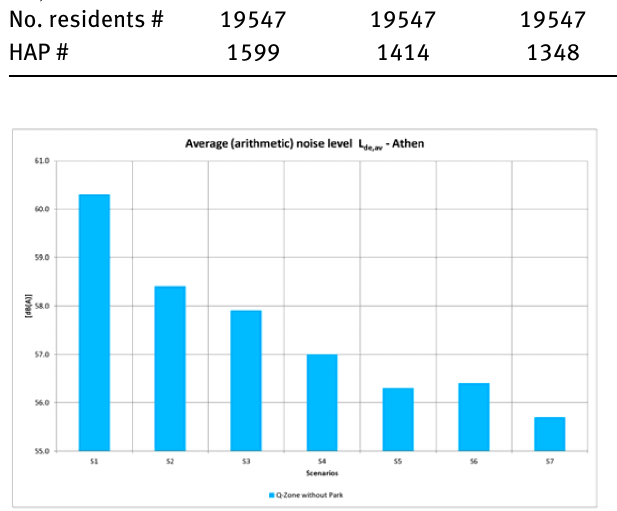
Figure 19: Average (arithmetic) noise level L Zone calculated without the park